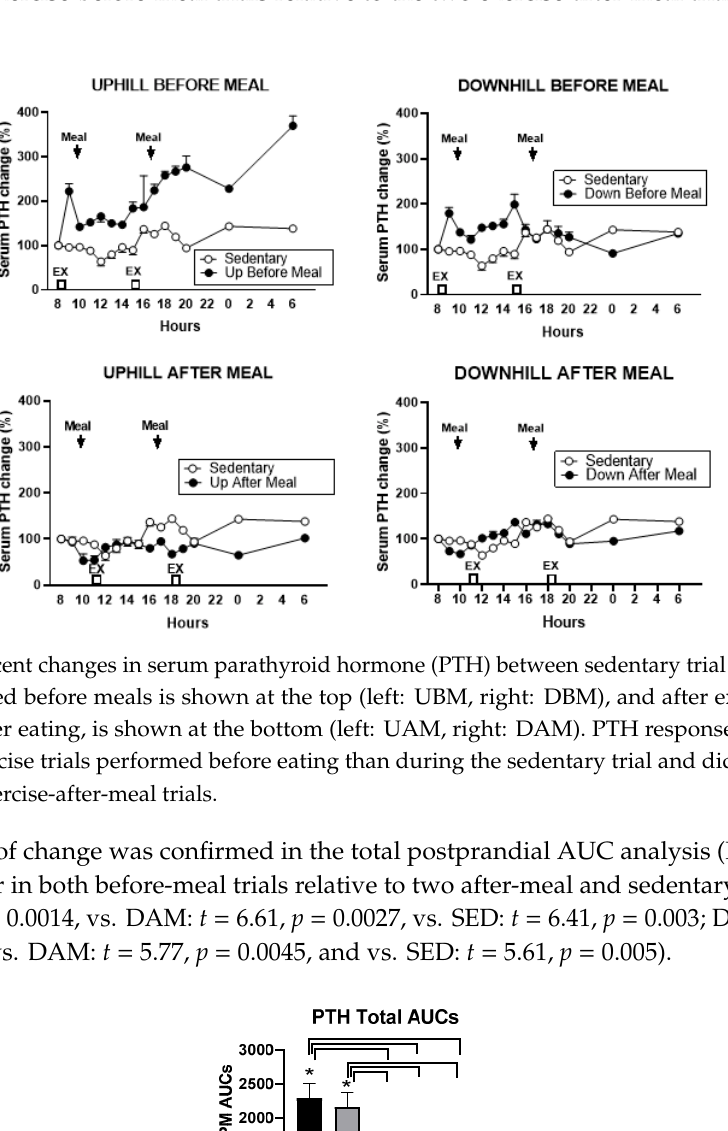
= 7.15, p = 0.002, vs. DAM: t = 5.77, p = 0.0045, and vs. SED: t = 5.61, p = 0.005). Nutrients 2019 , 11 , x FOR PEER REVIEW